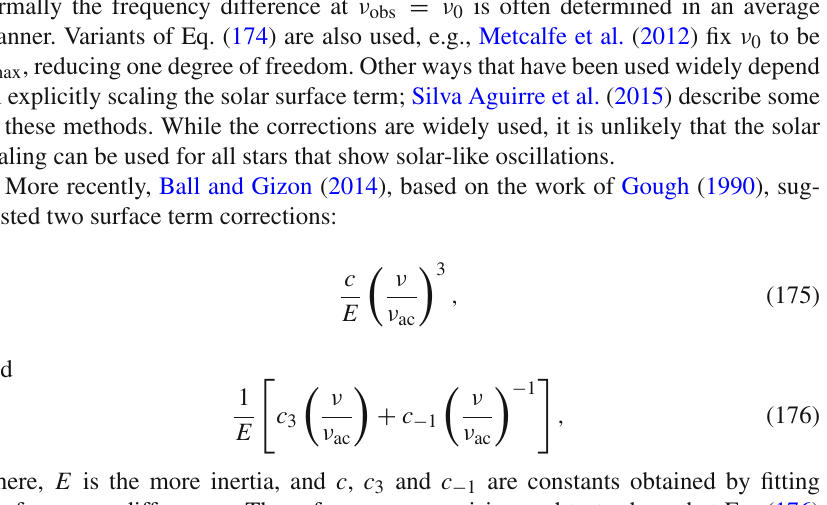
Fig.41 a Theéchelle diagramforlow-degreesolar modes( red ) andModel S( blue ). b Theéchelle diagram for 16 Cyg A ( red ) and a model of that star ( blue ). Note that in both panels, the échelle diagram of the model deviates from that of the star at high frequencies. This is nothing but the surface term ν 0 . The exponent is determined using the solar surface term. The quantity a ,